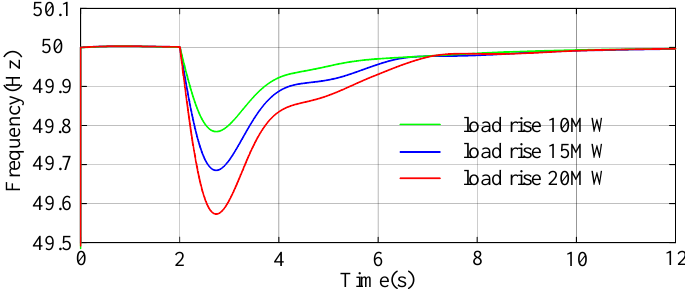
Figure 15. System frequency regulation result of low wind speed.